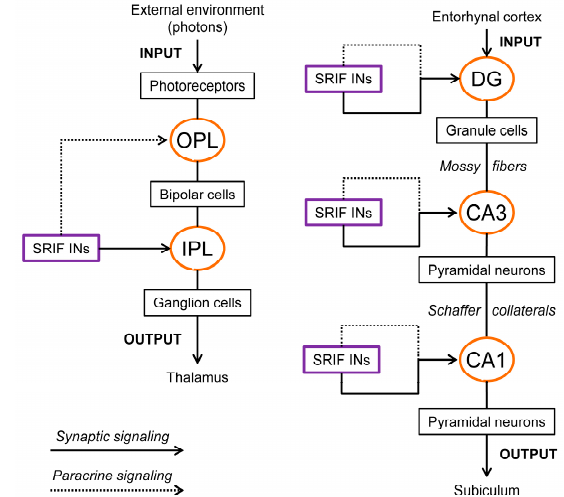
Figure 7. Schematic drawings of the retinal (left) and hippocampal (right) circuitries. The principal neurons form a main line of information flow with synaptic stations (orange circles) in specific zones of the anatomical formation. Somatostatinergic interneurons (SRIF INs) form parallel microcircuitries that control the information transfer between principal neurons. In the retina, SRIF INs are all located near the IPL and have extensive arborizations spanning horizontally. However, somatostatin can reach the OPL through diffusion (paracrine signaling), thanks to the compact organization of the retinal layers that keeps the two synaptic stations close by. In the hippocampus, on the contrary, the axons of the principal cells have to cross considerable distances to reach next synaptic station. Consequently, somatostatinergic interneurons occur in each hippocampal subfield, where they form local microcircuitries. Based on the synaptology of hippocampal SRIF INs and on the wide distribution of somatostatin receptors through all subcellular districts of principal cells, it is conceivable that a diffuse action (paracrine signaling) may also occur in addition to synaptic signaling.